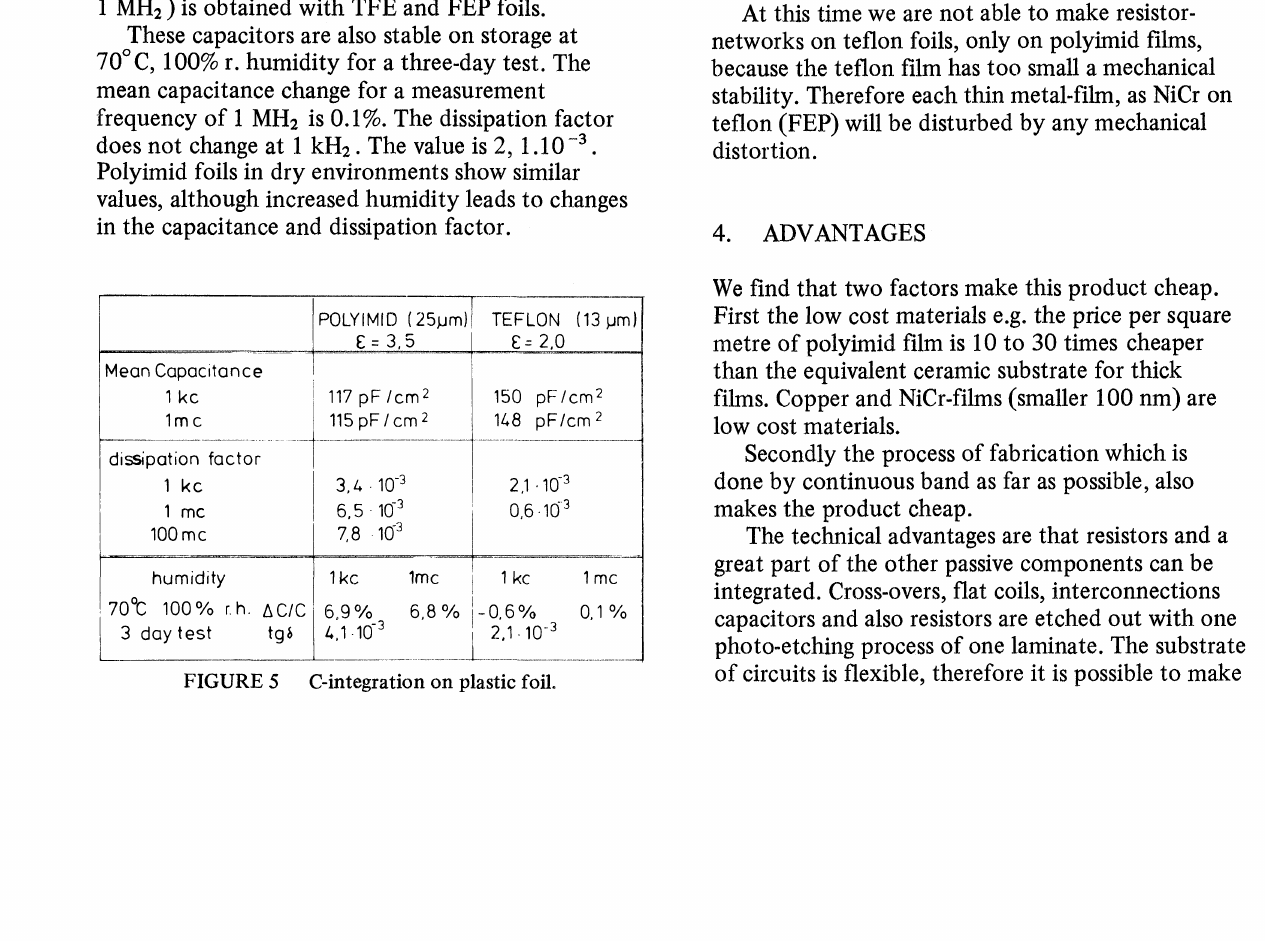
R-C Integration on plastic